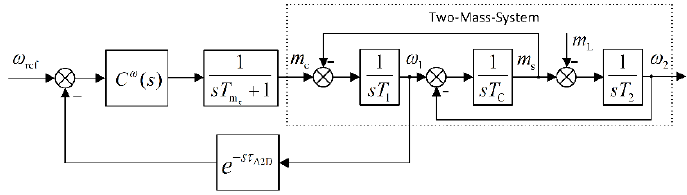
Figure 2. A block diagram of the considered control structure.